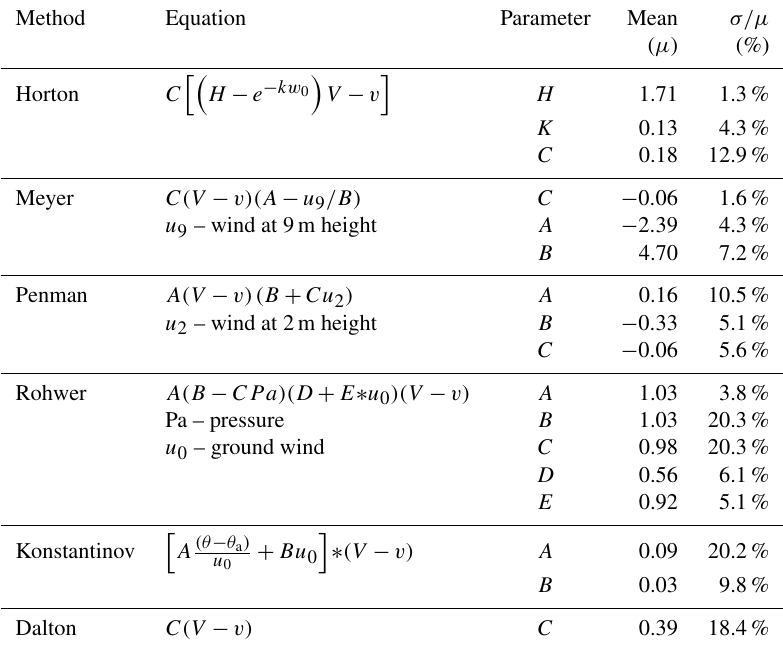
Table 3. Parameter uncertainty comparison between six evaporation formulas (mean µ and σ/µ